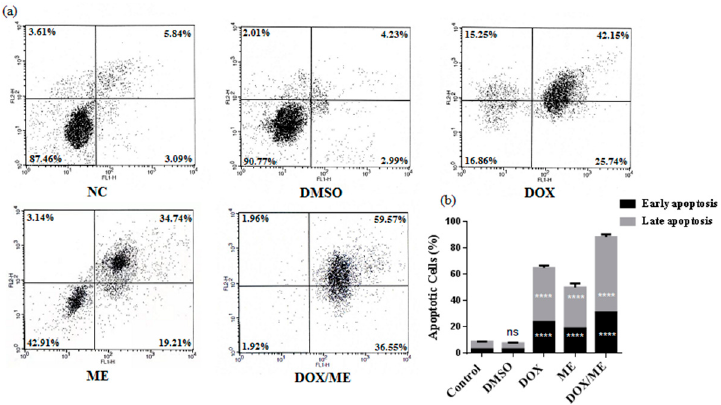
Figure 4. Apoptosis induction in Caco-2 cells. FACS histograms ( a ) and quantitative analysis of early and late apoptosis ( b ). Cell populations were stained with Annexin V/PI (the lower left quadrant demonstrates viable cells, upper left quadrant shows early apoptotic, the upper right quadrant represents late apoptotic and the lower right quadrant shows necrotic cells populations). Cells were treated for 48 h with Dox (IC 50 ) or ME (IC 50 ) or with the combination of ME (IC 10 ) and Dox (IC 50 ). Data represent the mean ± standard deviation of the mean of 3 independent experiments; ns (not significant), **** p < 0.0001 compared to the untreated DMSO control by one-way